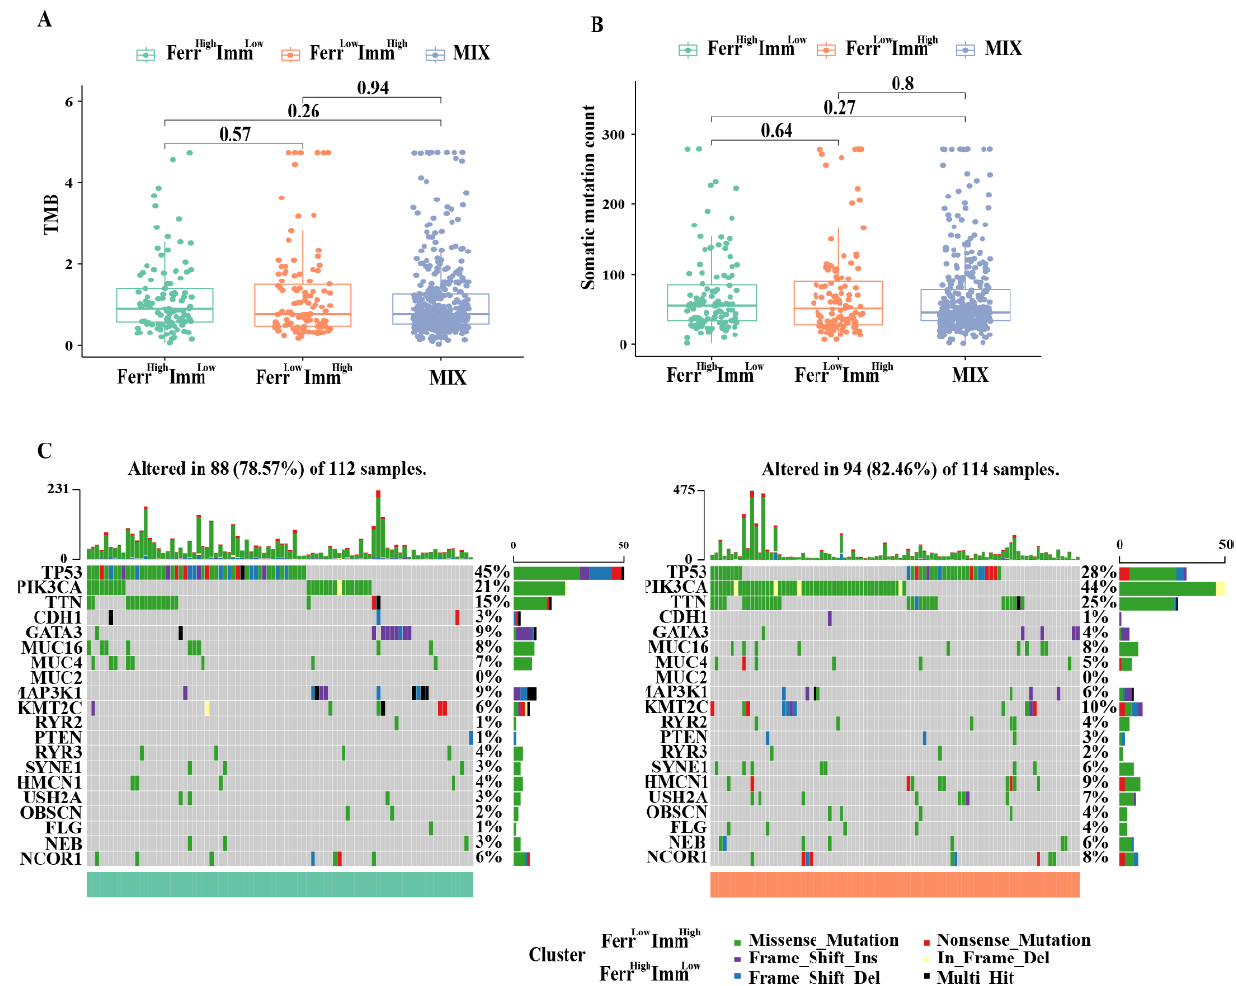
Figure 6. Relationship with tumor mutations in different subtypes: ( A ) Tumor mutational burden (TMB) of the three subtypes. ( B ) The number of mutated genes evaluated in the three subtypes ( C ). Frequency and type of mutations in the top 20 genes in Ferr High Imm Low and Ferr Low Imm High group. Genes are sorted according to frequency of mutations.